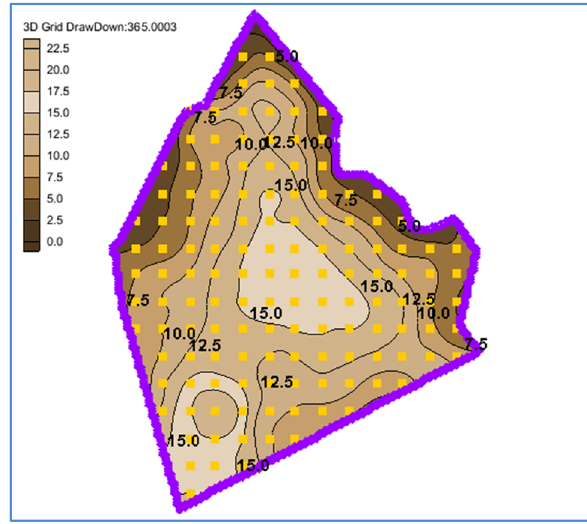
Figure 10: Drawdown after 12 h of operation with a discharge equal to 430 m 3 /day for each well.